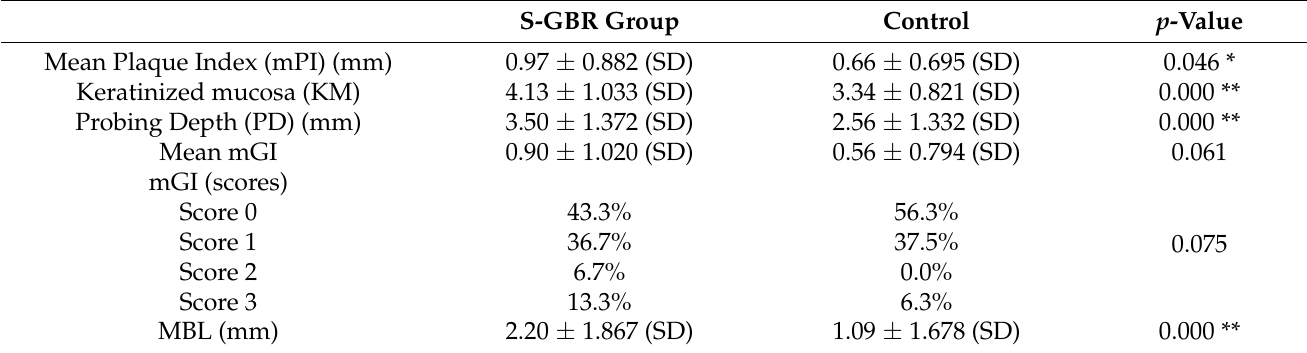
Table 6. Clinical parameters and radiographic results at 24-months follow-up.